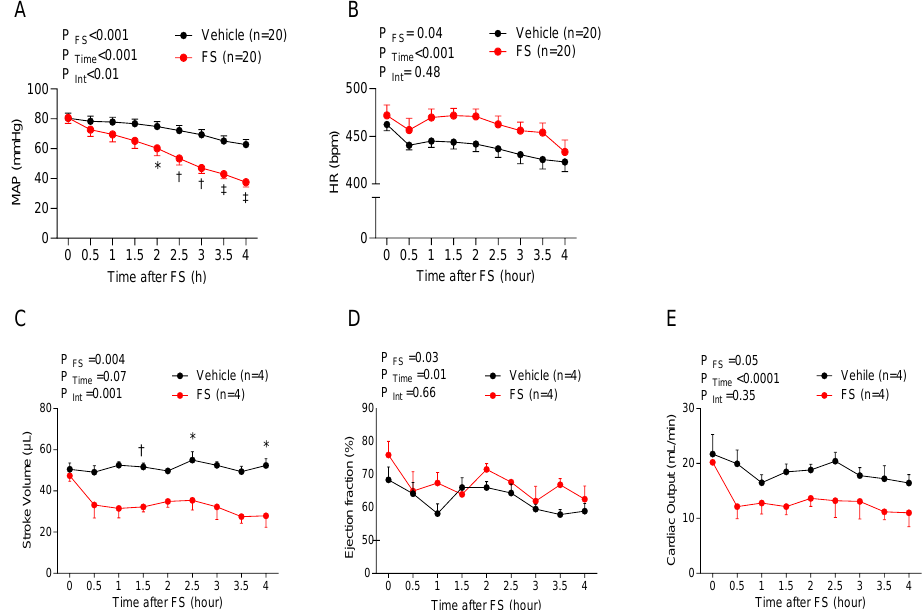
Figure 1. Fecal slurry (FS)-induced peritonitis affected ( A ) mean blood pressure (MAP), ( B ) heart rate (HR), ( C ) stroke volume, ( D ) ejection fraction, and ( E ) cardiac output. Data were analyzed by two-way ANOVA for the effects of FS and time, followed by the Holm–Sidak post hoc test for multiple comparisons. * p < 0.05, † p < 0.01, and ‡ p < 0.001 compared with the vehicle at the same time.